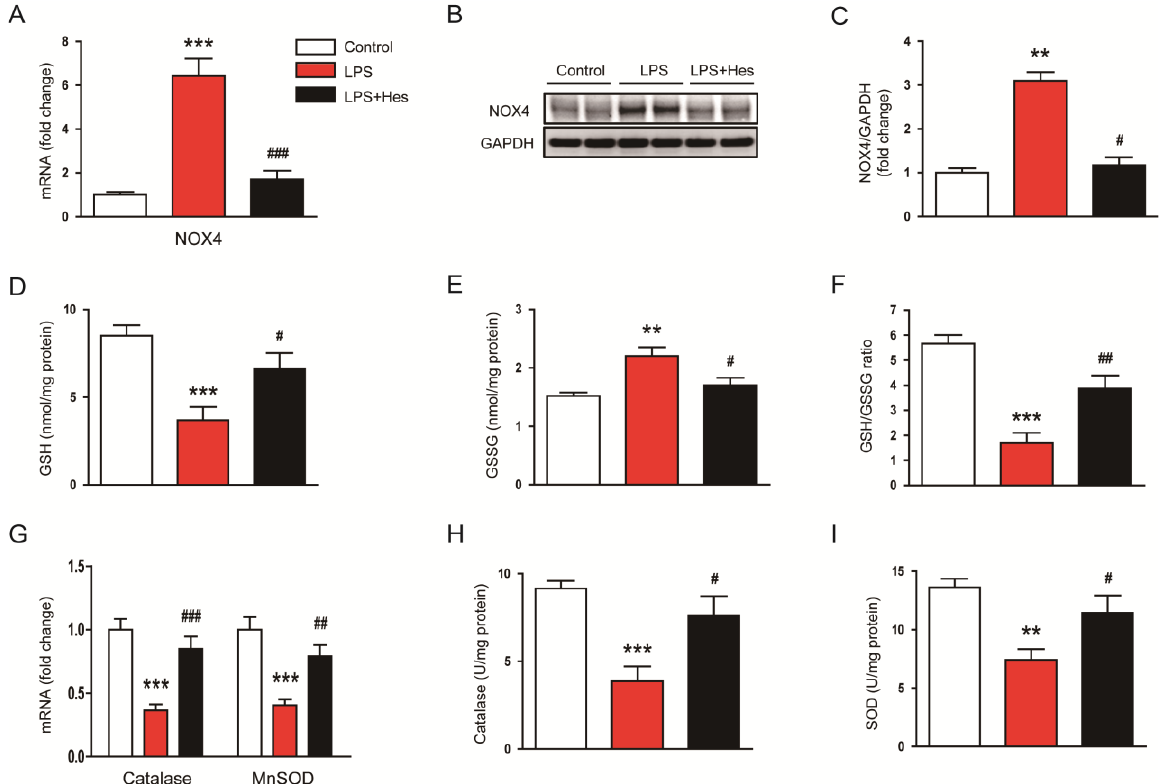
Figure 5. Hesperetin regulated pro-oxidant and antioxidant enzymes. ( A ) Renal mRNA expression of NADPH oxidase 4 (NOX4). ( B ) Western blotting of NOX4. ( C ) Densitometric analysis of bands in (B). ( D ) Renal levels of reduced glutathione (GSH). ( E ) Renal levels of oxidized glutathione (GSSG). ( F ) GSH/GSSG ratios. ( G ) Renal mRNA expression of catalase and manganese superoxide dismutase (MnSOD). ( H ) Catalase activity. ( I ) SOD activity. n = 8 per group. ** p < 0.01 and *** p < 0.001 vs. Control. # p < 0.05, ## p < 0.01 and ### p < 0.001 vs. LPS.